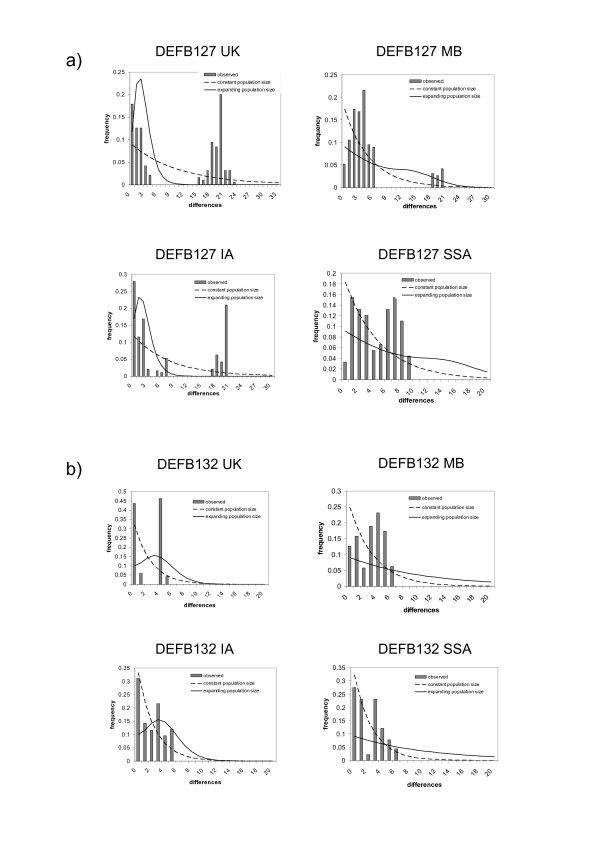
Mismatch analysis of DEFB127 and DEFB132 haplotypes. Mismatch analysis plots are shown for each population, together with a simulated plot assuming neutrality and a sudden population expansion. 95% Confidence intervals to the simulated values were determined by bootstrap analysis. a) DEFB127. b)DEFB132.